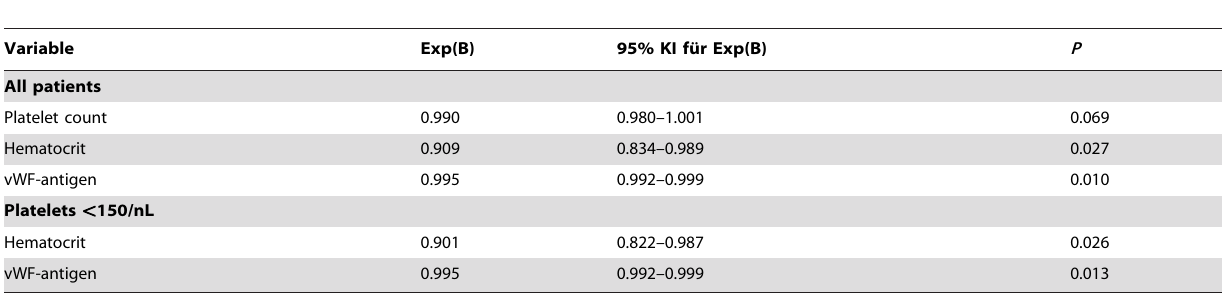
Table 6. Results for multivariate analysis of predictors of a pathological PFA-100 test result.